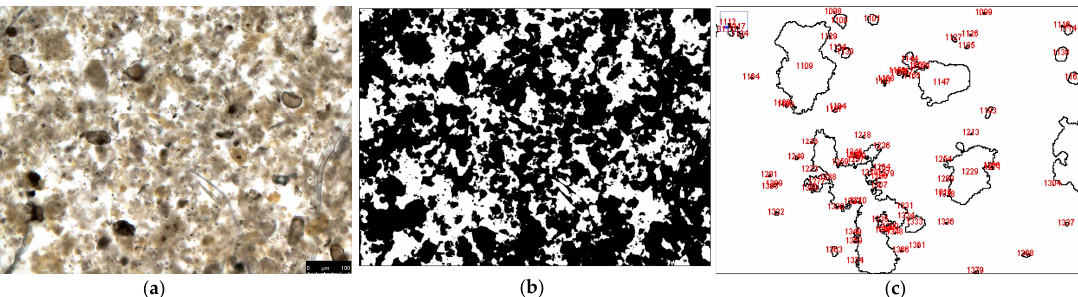
Figure 3. Determination of the particle size by image processing and analysis: ( a ) the original sample image, acquired under the light microscope; ( b ) the sample image after the adjusted threshold; ( c ) 200% magnified area in the image after particle analysis.